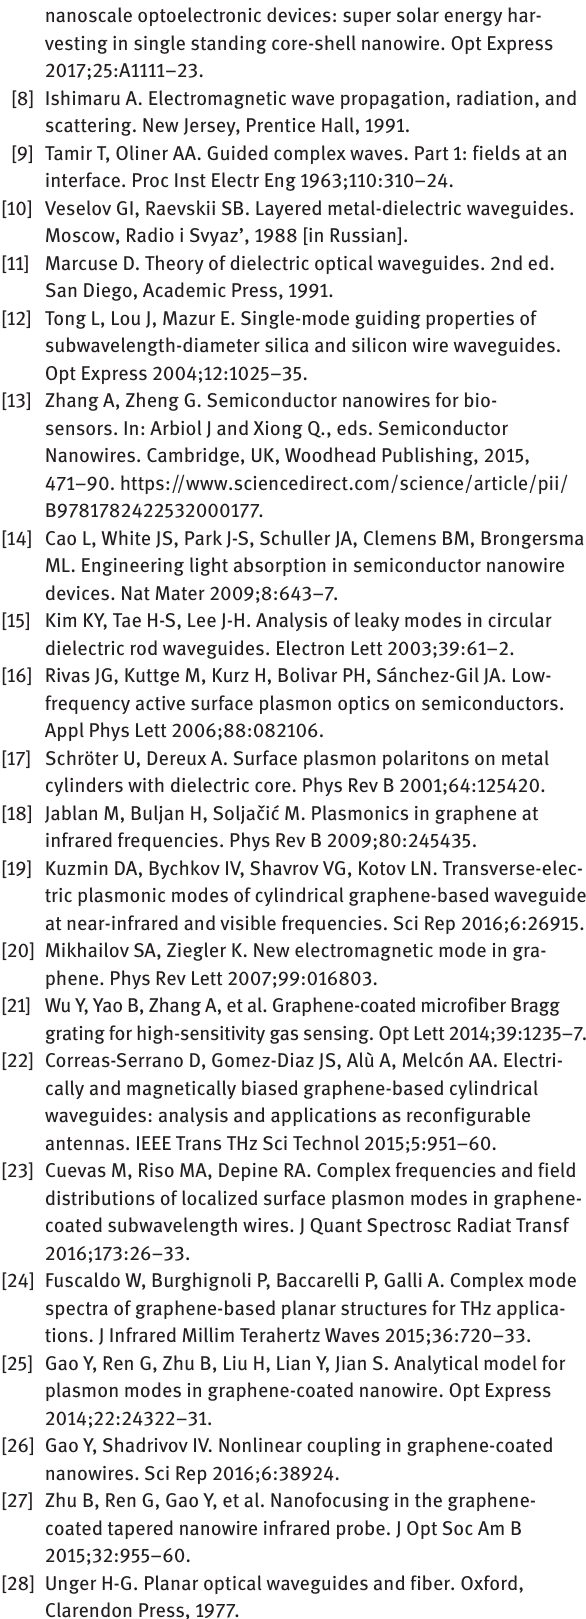
Table A1: Systematization of proper and improper complex waves.